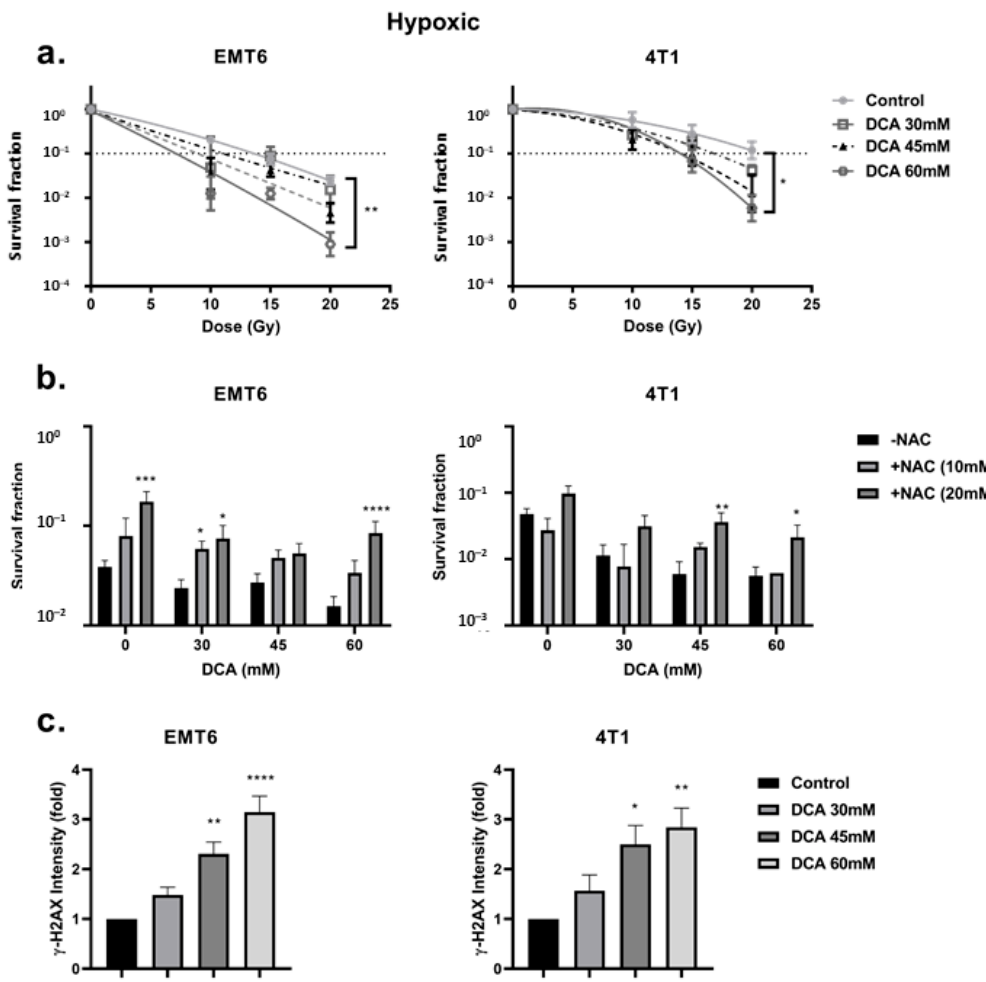
Figure 5. DCA radiosensitizes hypoxic tumor cells via the upregulation of ROS. EMT6 and 4T1 cells were treated with DCA overnight at indicated concentrations. ( a ) The radiosensitizing effect of DCA under hypoxic conditions assessed by colony formation assay. ( b ) Pretreatment of NAC (10 mM and 20 mM) reversed the radiosensitizing effect of different concentrations of DCA at 15 Gy for EMT6 and 20 Gy for 4T1. ( c ) Double-strand DNA breaks were analyzed by flow cytometry using gammaH2AX staining. * p < 0.05, ** p < 0.01, *** p < 0.001, **** p < 0.0001.